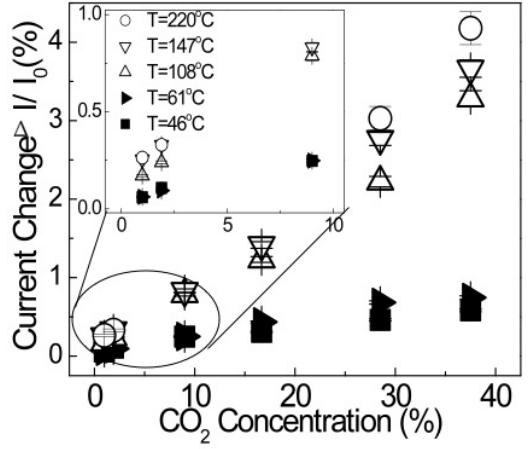
Figure 16. The drain current changes of HEMT sensor as a function of CO The inset is the current change of the sensors as function of lower CO 10%).